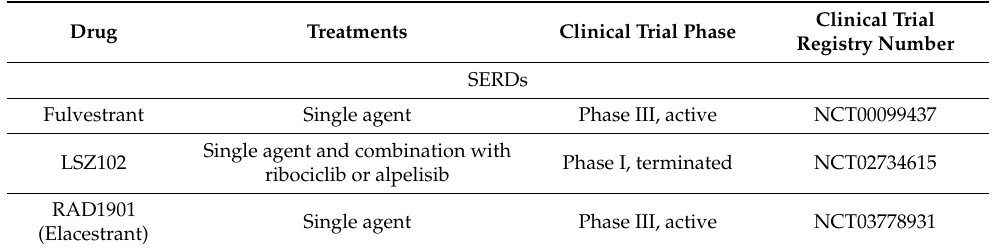
Table 1. Clinical trials of anti-estrogen therapy-resistant